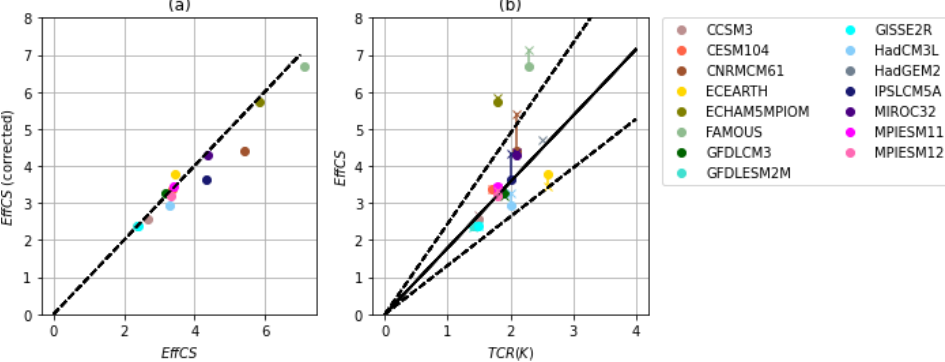
Figure A3. (a) Corrected EffCS plotted as a function of uncorrected EffCS. (b) EffCS (crosses) and corrected EffCS (circles) plotted as a function of transient climate